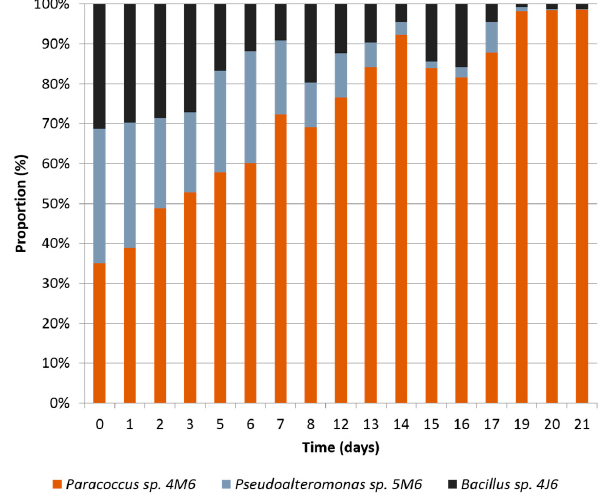
Figure 9. Proportion of planktonic bacterial strains in Photobioreactor (PBR) during experiment. The determination was realized by enumeration on agar plate. Data represent the mean of replicates.